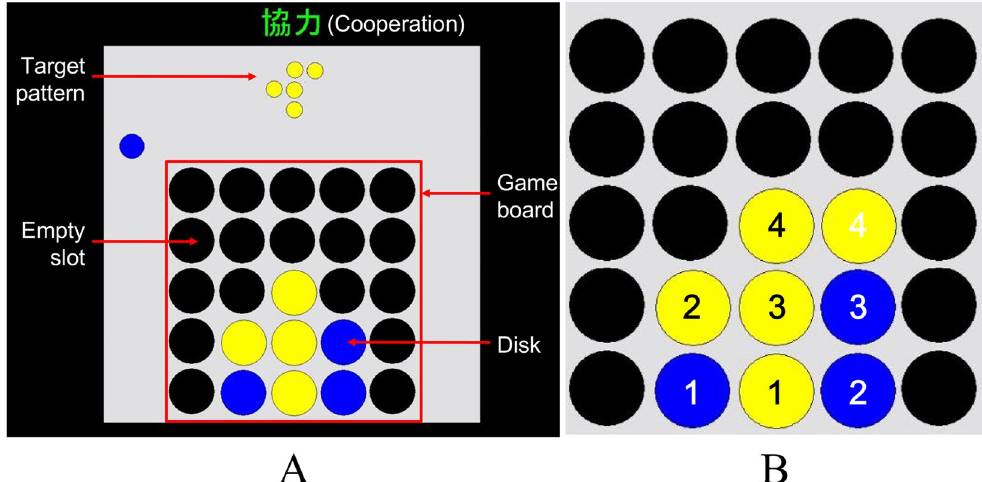
Figure 1. Explanations on ( A ) the turn-taking disk-game task and ( B ) the modification of the game-ending rule in the present study. The left illustration shows a clip from a cooperative game (the arrows and words were not displayed in the experimental game). The small blue disk above the game board initially appeared on the top-left side, indicating that it was the Blue player’s turn to play. Participants could only control the horizontal left and right moves of the disk using a keypad to reach the desired column. The Yellow player always took the initial move, and the Blue player followed. The numbers in the right illustration indicate the orders of the moves of the Yellow and Blue